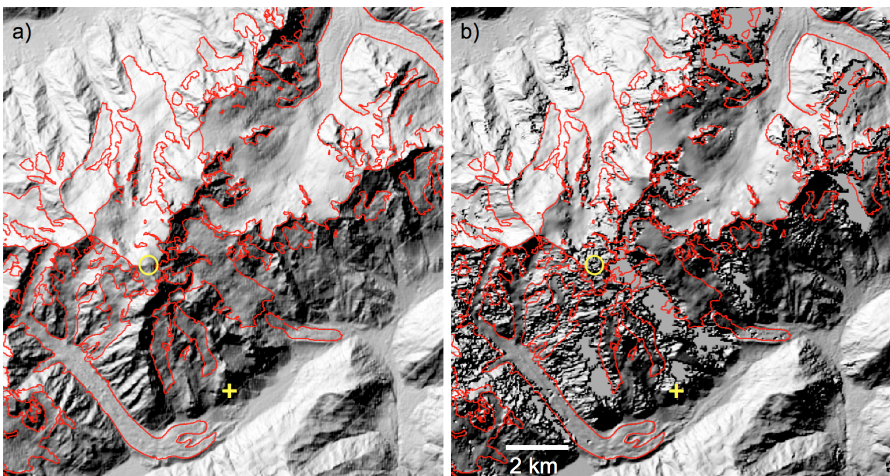
Figure 2. Comparison of hillshade views from (a) the AW3D30 DEM and (b) the TanDEM-X DEM for a region around Mont Blanc (Monte Bianco). Glacier outlines are shown in red, and data voids in the TanDEM-X DEM are depicted as constantly grey areas. The yellow circle marks the Mont Blanc summit, and the yellow cross in the lower centre marks the coordinates 45.8 ◦ N and 6.9 ◦ E. The AW3D30 DEM was downloaded from https://www.eorc.jaxa.jp/ALOS/en/aw3d30/index.htm (last access: 24 July 2019) and is provided by